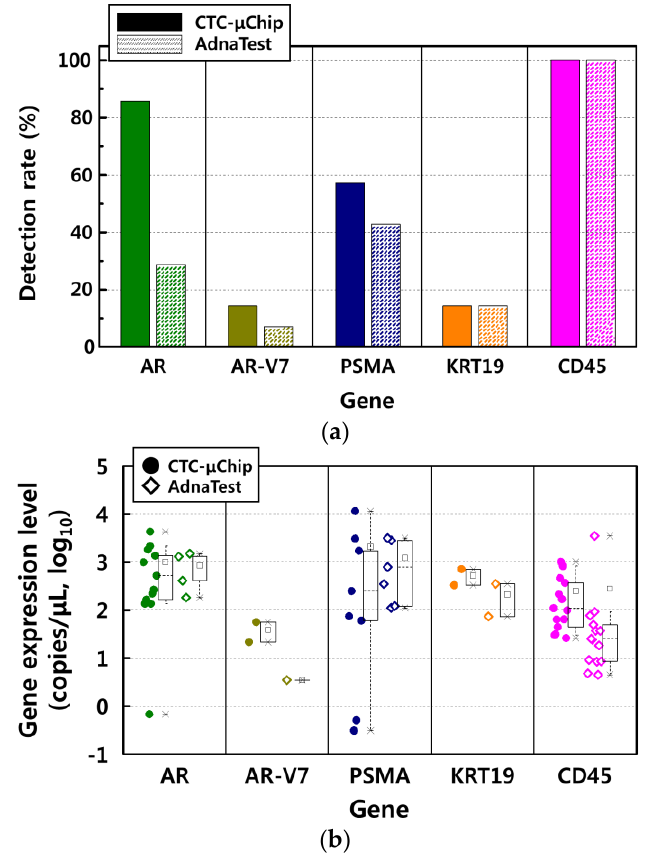
Figure 5. ( a ) The detection rate and ( b ) expression levels (copies/µL) of the selected five genes of androgen receptor (AR), androgen receptor splice variant 7 (AR-V7), prostate-specific membrane antigen (PSMA), cytokeratin 19 (KRT19), and protein tyrosine phosphatase receptor type C (CD45). The p -value of gene expression was statistically analyzed for the two isolation methods, giving results of 0.09 for AR, 0.825 for AR-V7, 0.454 for PSMA, 0.468 for KRT19, and 0.920 for CD45 with 95% confidence interval